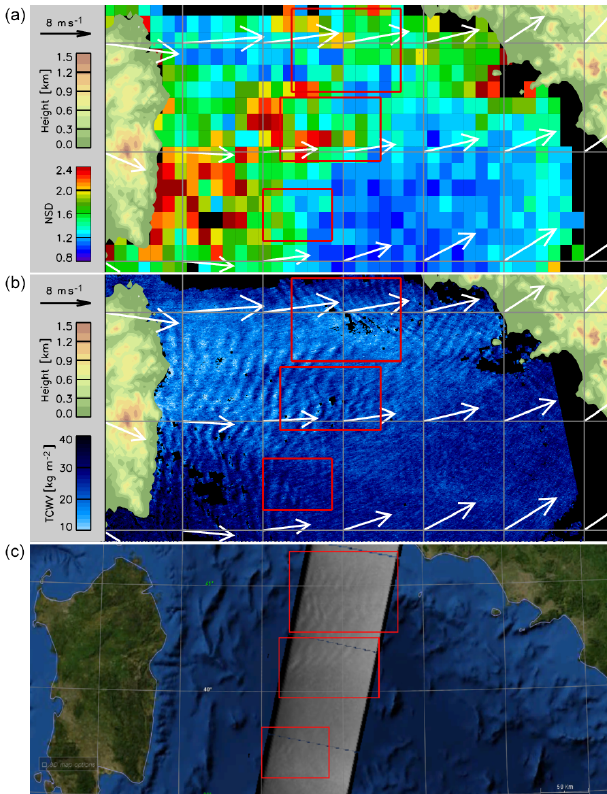
Figure 5. 18 July 1997 over Tyrrhenian Sea. (a) NSD derived from the AIRWAVE TCWV fields (shown in b ), ATSR-2, orbit 11734 (ascending), with measurements acquired at 21:14. The arrows rep- resent the wind speed (length) and direction, as derived from ERA- Interim fields at 1 . 0 ◦ × 1 . 0 ◦ resolution. (c) ERS-2 SAR single-look complex images; track 351; frames 2763, 2781, 2799 and 2817; and orbit 11728 (descending), with measurements acquired at